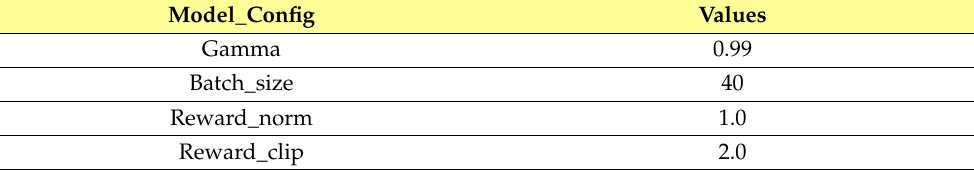
Table 1. The parameter values of the proposed